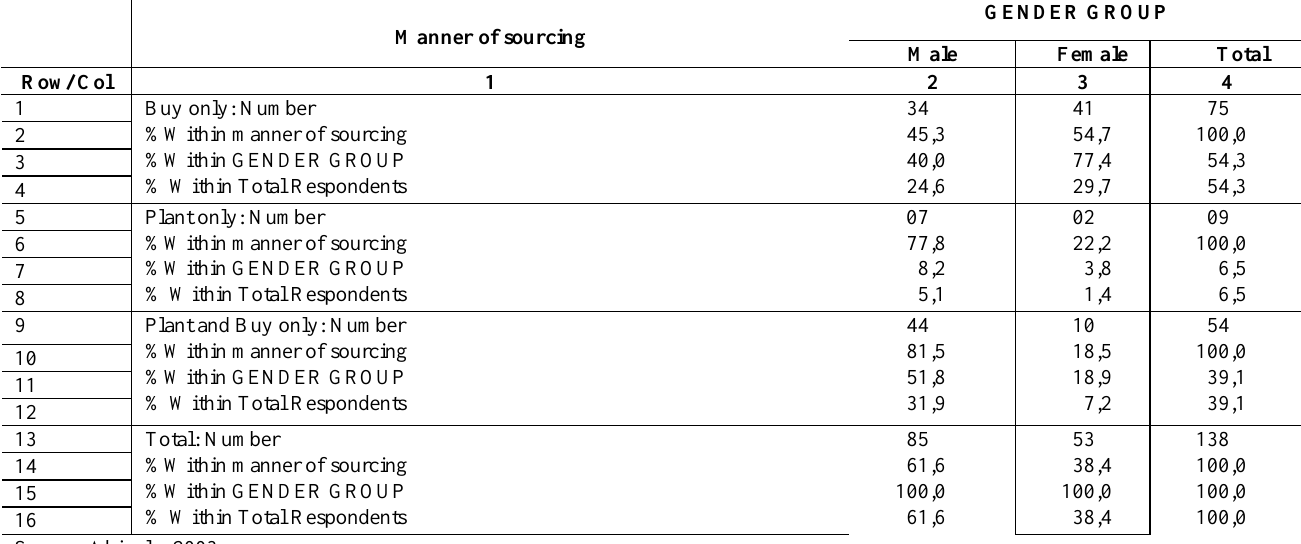
Table 7: Manner of sourcing Cocoa Beans marketed by gender, Ondo State of Nigeria, 2000/2001 season. Manner of sourcing